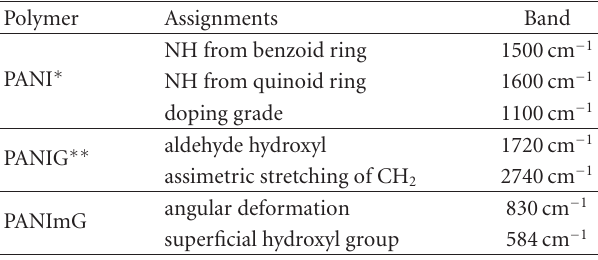
Table 1: Comparative FT-IR bands of PANI, PANIG, and PANImG.